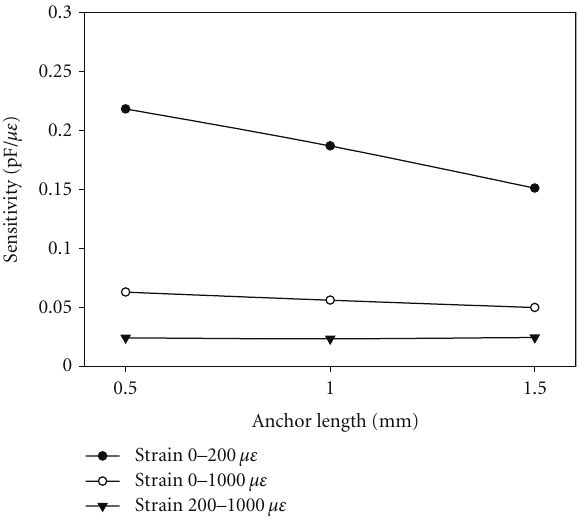
Figure 10: Sensitivity comparisons at di ff erent strain range for all the three dielectric coverage.